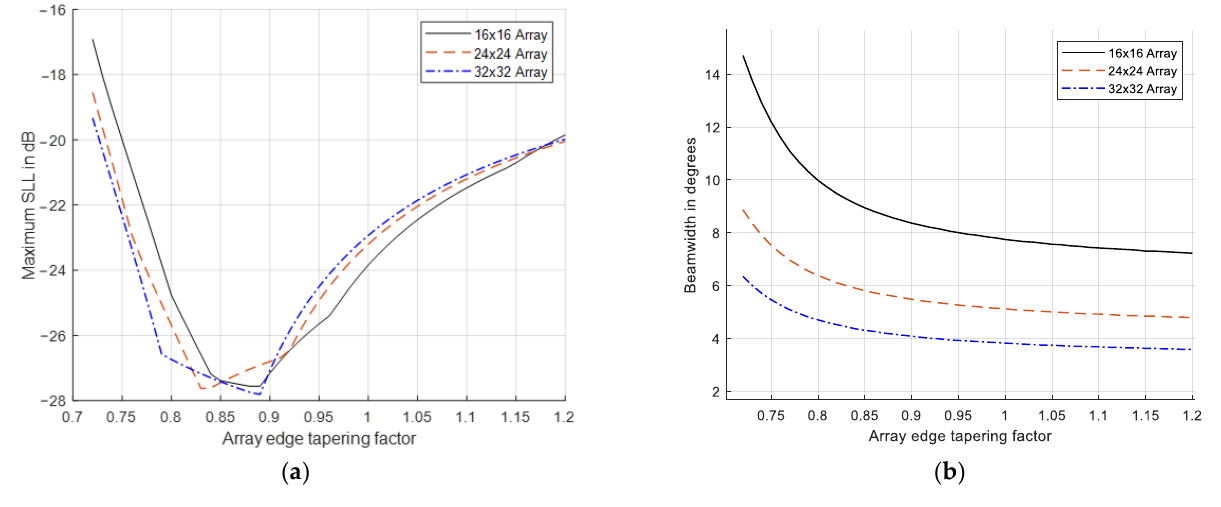
Figure 8. ( a ) Optimizing radial tapered triangular window at different array sizes. ( b ) Beamwidth variation with the array edge tapering factor at different array sizes.